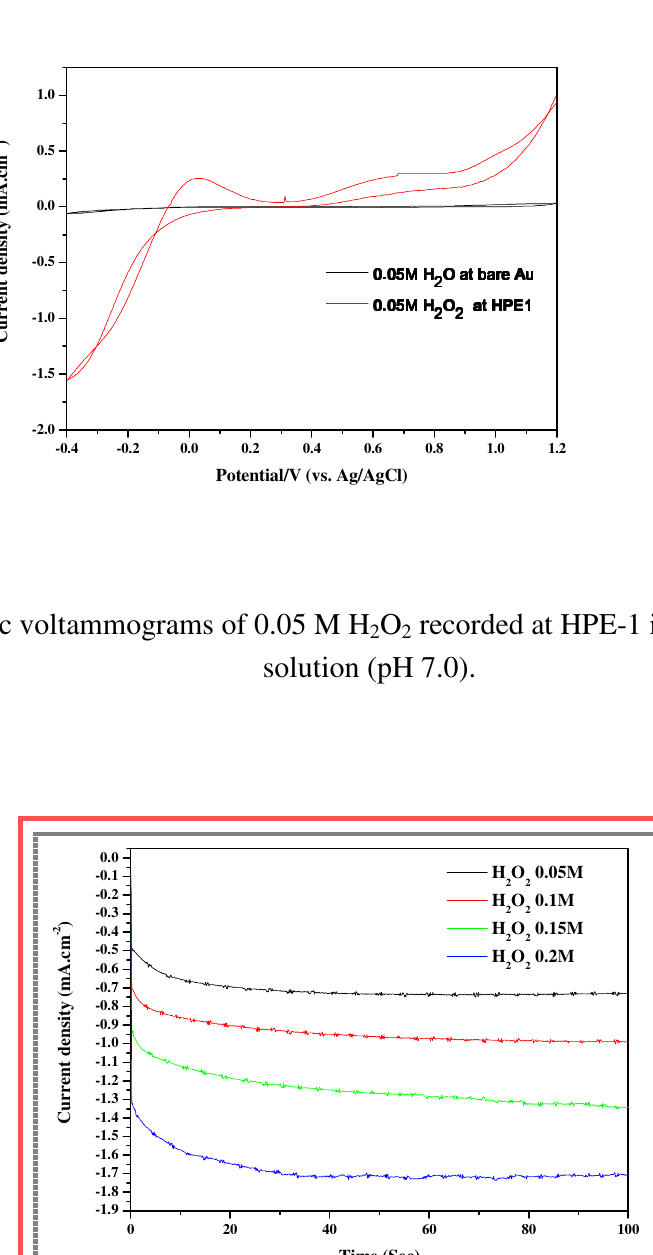
O in 0.1 M phosphate buffer 2 2